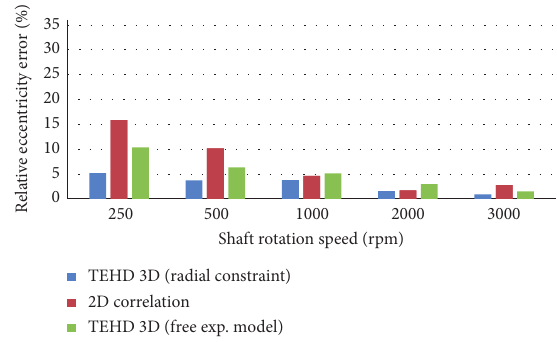
Figure 21: Difference between relative eccentricities measured and computed by means of most consistent 3D and 2D models for the modified RK in configuration 1.